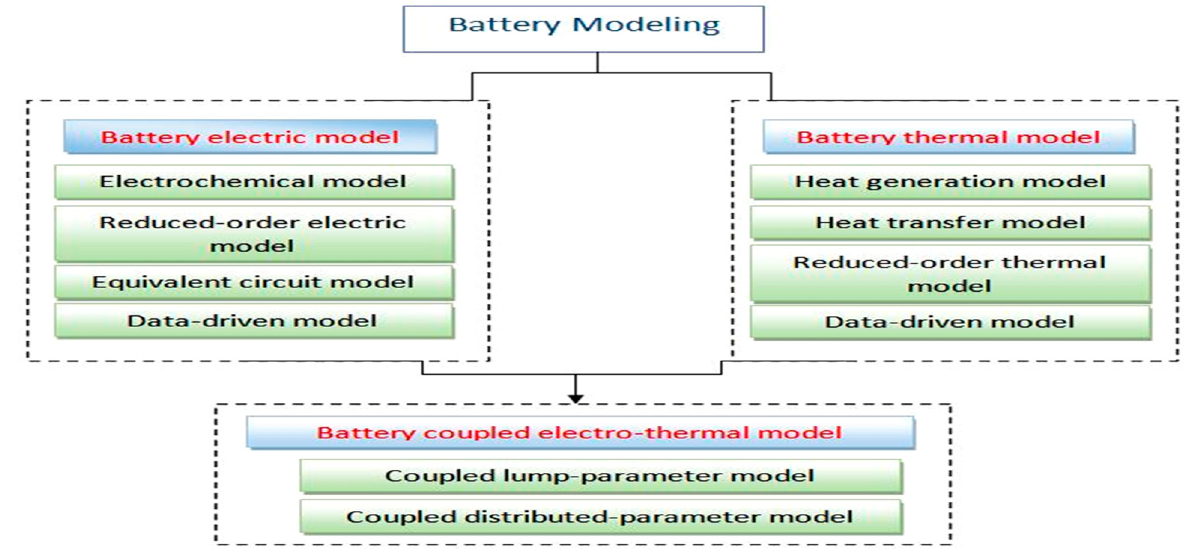
Figure 5. Classifications of battery modeling. Adapted from [4].